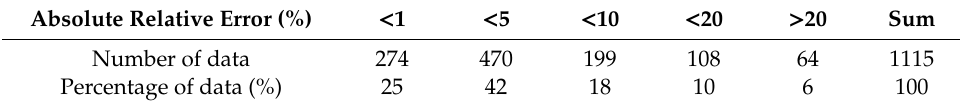
Table 3. Distribution of the absolute relative error of the neural network model.